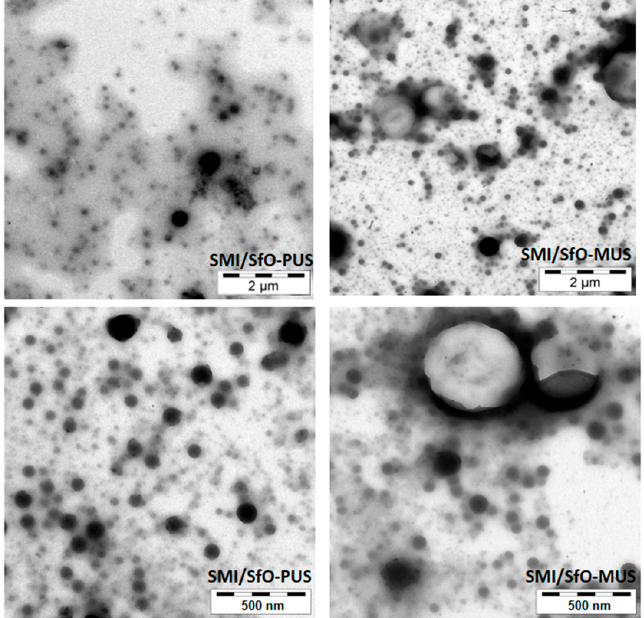
Figure 4. Transmission electron microscopy (TEM) of SMI/SfO-PUS and SMI/SfO-PUS nanoparticles at different magnifications.